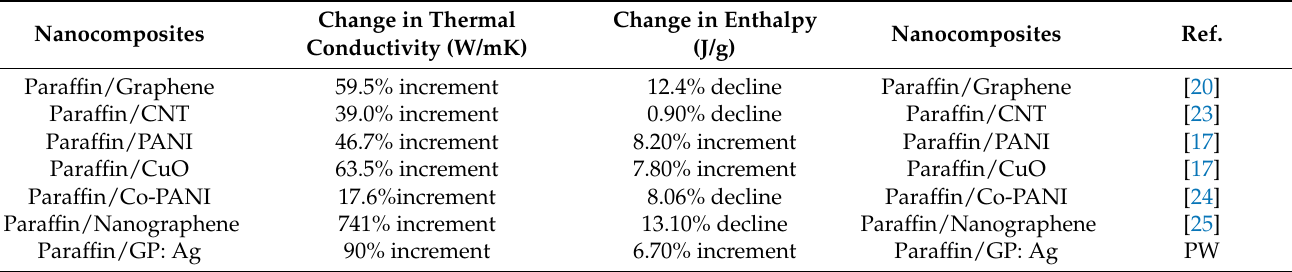
Table 1. Thermophysical properties of wax-based